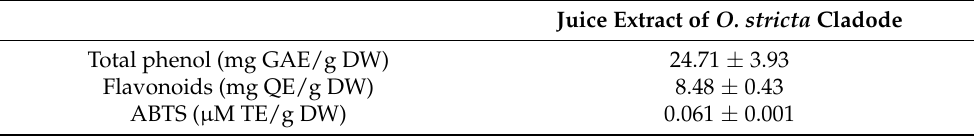
Table 1. Total phenolic content and total flavonoids of juice extract of O. stricta cladode. Juice Extract of O. stricta Cladode Total phenol (mg GAE/g DW) 24.71 ± 3.93 Flavonoids (mg QE/g DW) 8.48 ± 0.43 ABTS ( µ M TE/g DW) 0.061 ±